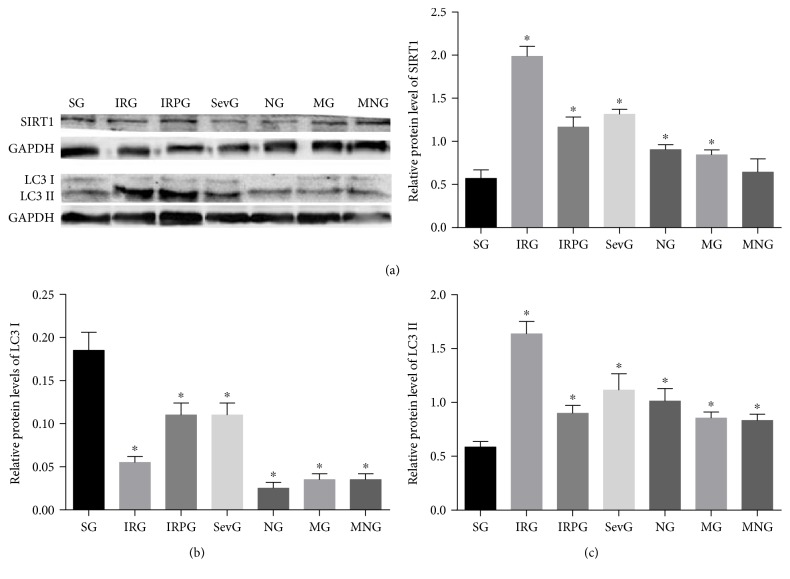
Western blot analysis for protein levels of SIRT1 and LC3 in different groups. (a) Relative protein levels of SIRT1. (b) Relative protein levels of LC3 I. (c) Relative protein levels of LC3 II. All data were represented as mean values ± S.D. ∗P < 0.05 via SG, n = 7.